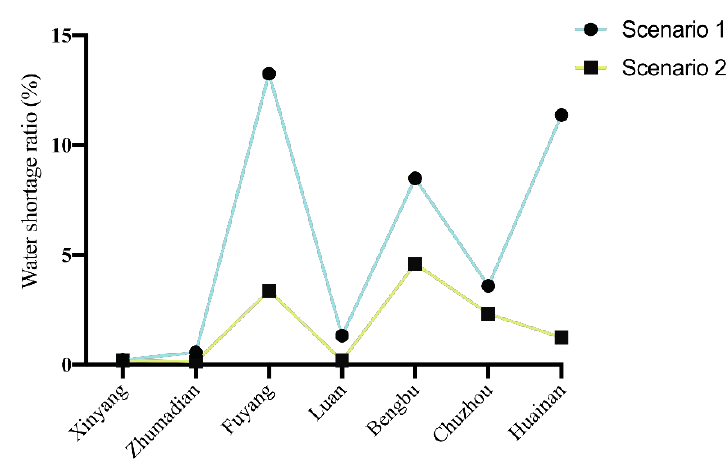
Figure 10. Water shortage rate of 7 cities under balanced weights.